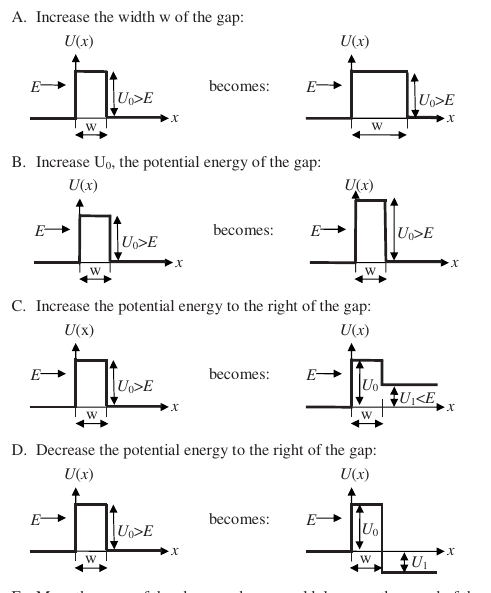
FIG. 7. A tunneling question from an early version of the QMCS. This question was developed to explore the belief that en- ergy is lost in tunneling. It has been removed from the QMCS because interviews suggest that responses from students in trans- formed courses are not necessarily indicative of whether students think energy is lost in tunneling.